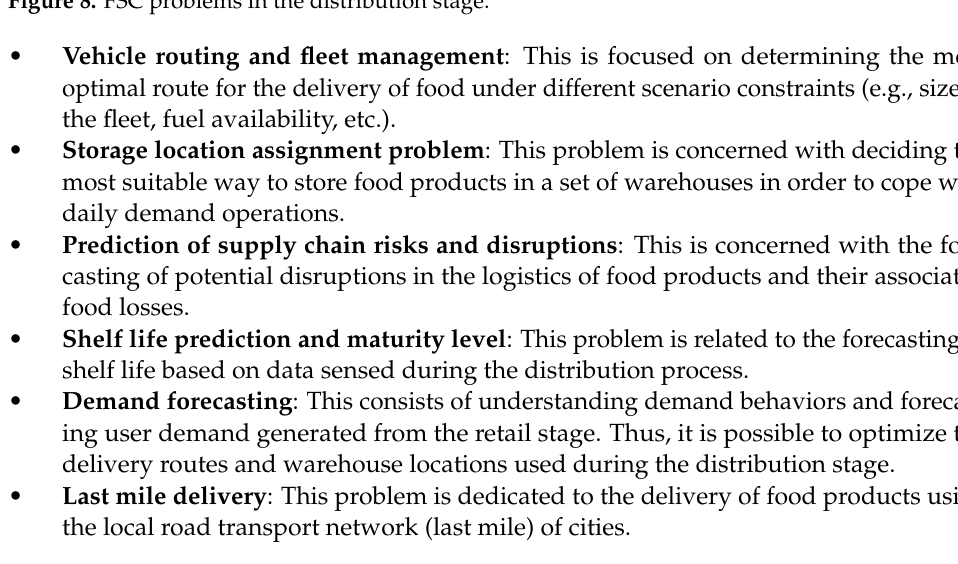
Figure 8. FSC problems in the distribution